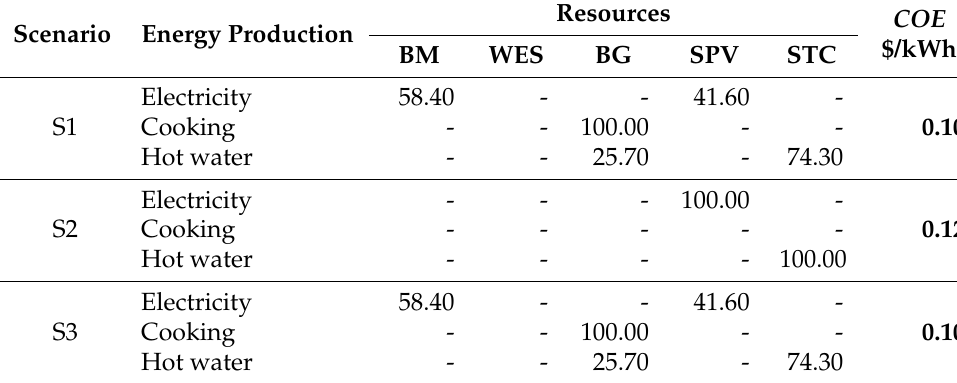
Table 3. Percentage contributions of renewable energy resources and cost of energy ( COE ) for all